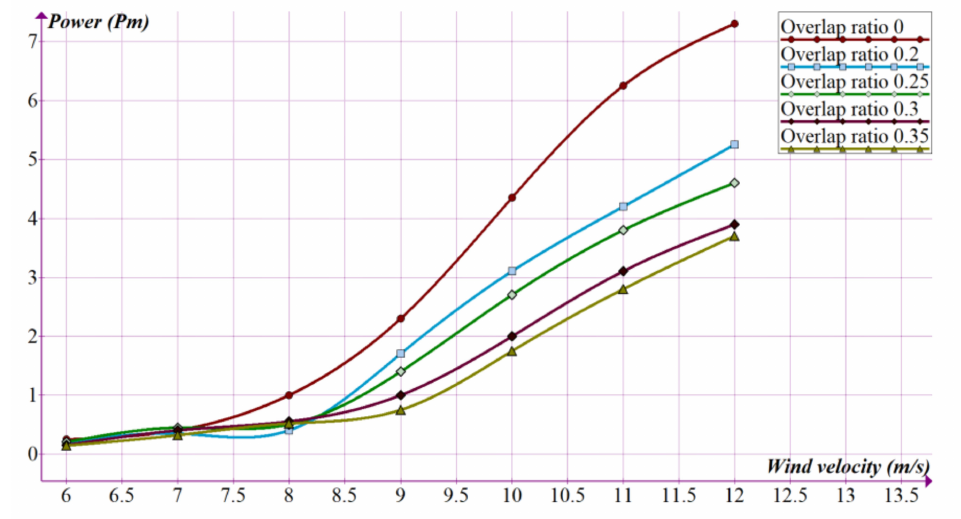
Figure 10. Power obtained for different overlap ratio values